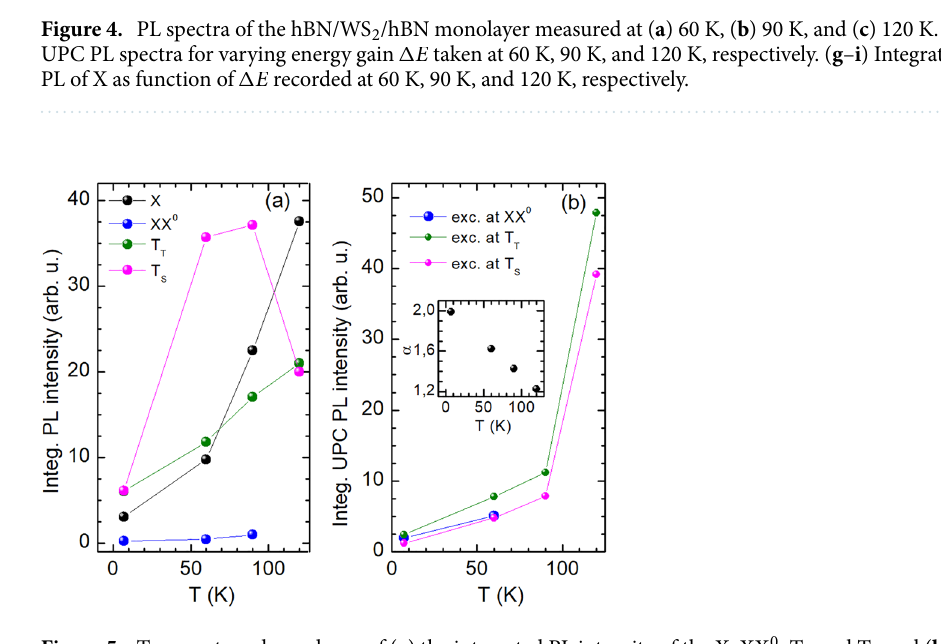
Figure 5. Temperature dependence of ( a ) the integrated PL intensity of the X, XX 0 , T T and T S and ( b ) the integrated UPC PL of the X excited at energies of the XX 0 , T T and T S . The inset of the panel ( b ) shows a / I UPC temperature evolution of the ratio α = I UPC T T S T